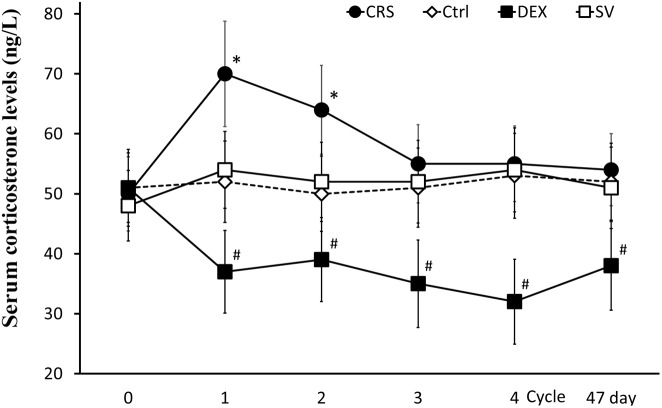
Changes in serum corticosterone levels. Serum corticosterone levels in CRS mice increased during the first two cycles (regardless of whether they developed hyperglycemia) and returned to normal after the 3rd cycle. Serum corticosterone remained low in DEX injected mice. There was no significant difference between solvent injection (SV) and normal controls (Ctrl). Data were shown as means ± SEM; ∗ compared with control mice, p < 0.01; # compared with solvent injection mice, p < 0.01.